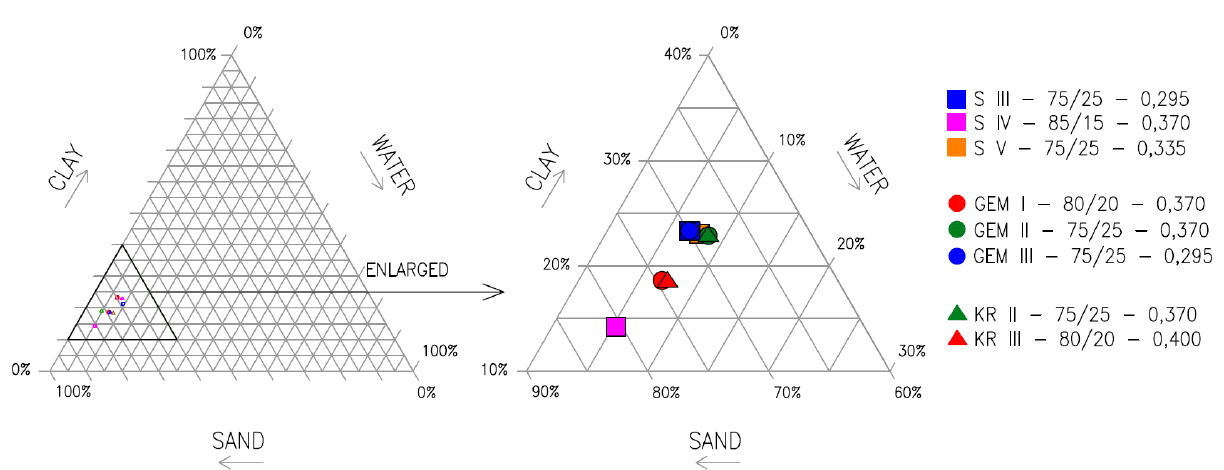
Figure 9. Prescription of used recepises in triangle diagram.